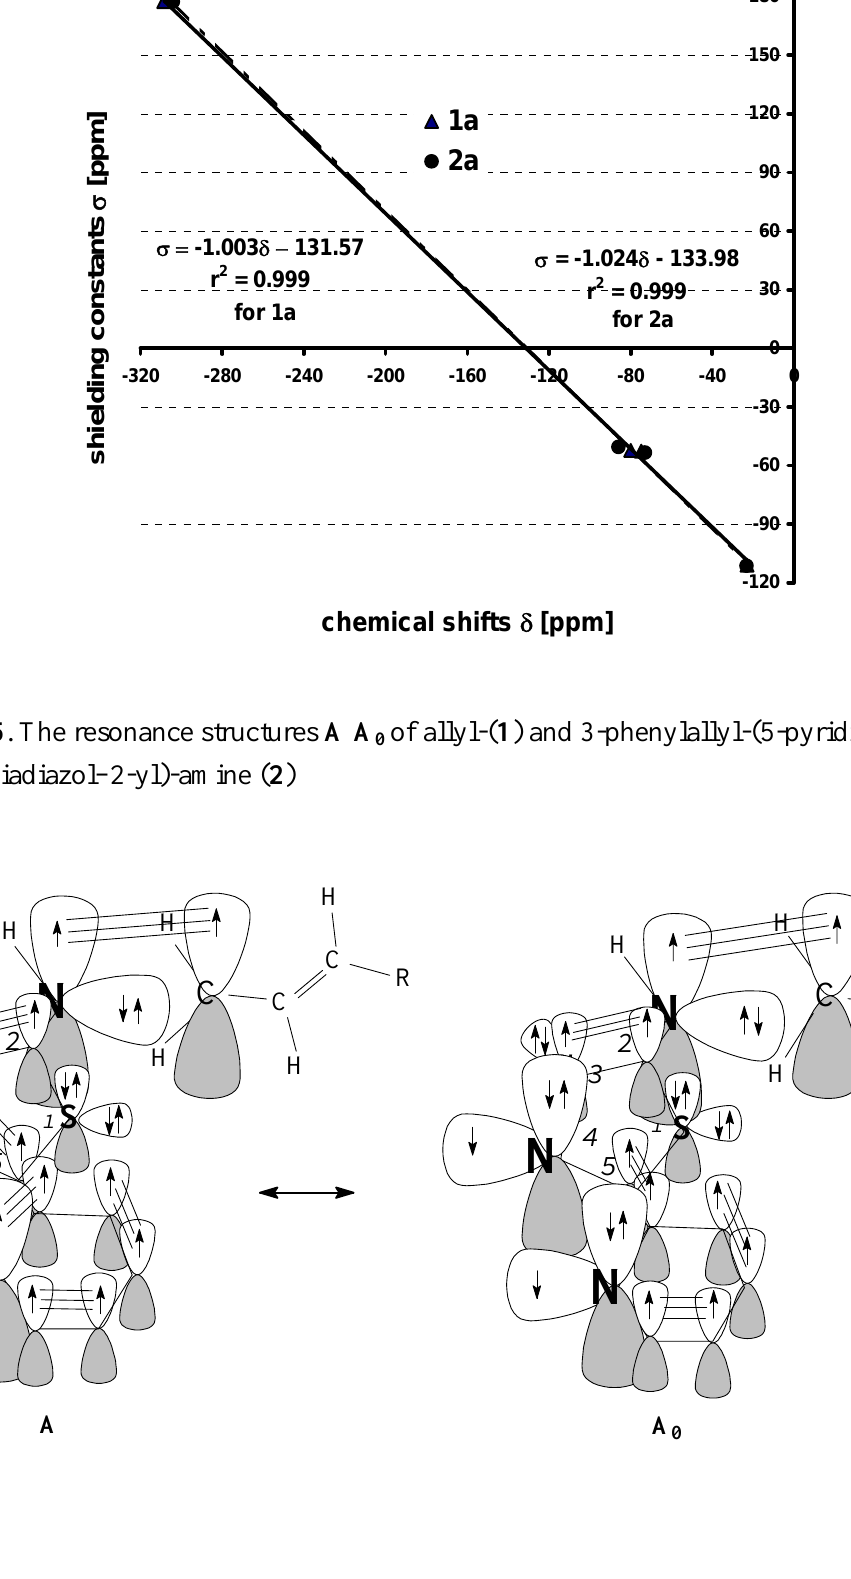
Figure 4. The linear regression of shielding constants σ [ppm] versus chemical shifts δ [ppm] for 1a and 2a .